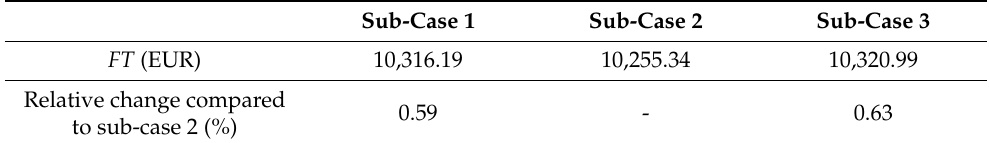
Table 9. Total fuel cost for case 1.